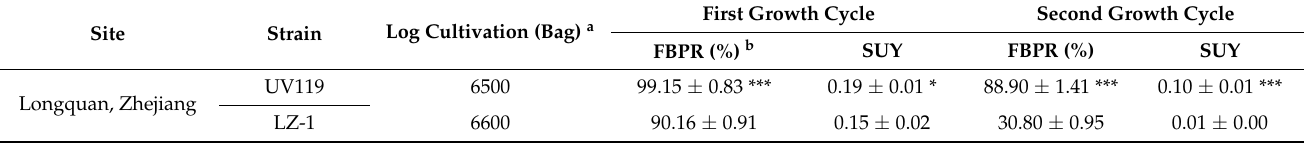
Figure 7. Production of spores during the strain cultivation. ( A ): Spore collection; ( B ): LZ-1; ( C ): mutagenic strain UV119. Table 6. Fruiting rate and spores yiled per unit of the two varieties in the two growth cycles.